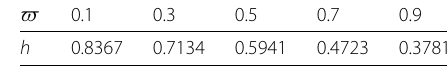
Table 3 Maximum allowable sampling period of h in Example